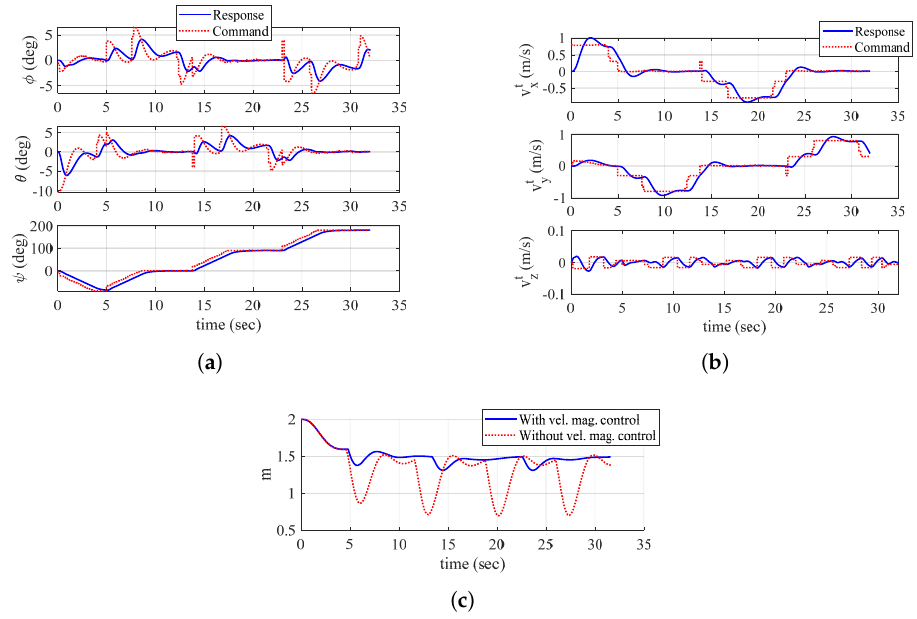
Figure 7. Time histories of UAV-related parameters (Simulation I): ( a ) attitude; ( b ) velocity (tangent–plane coordinate system); and ( c ) minimum distance between UAV and